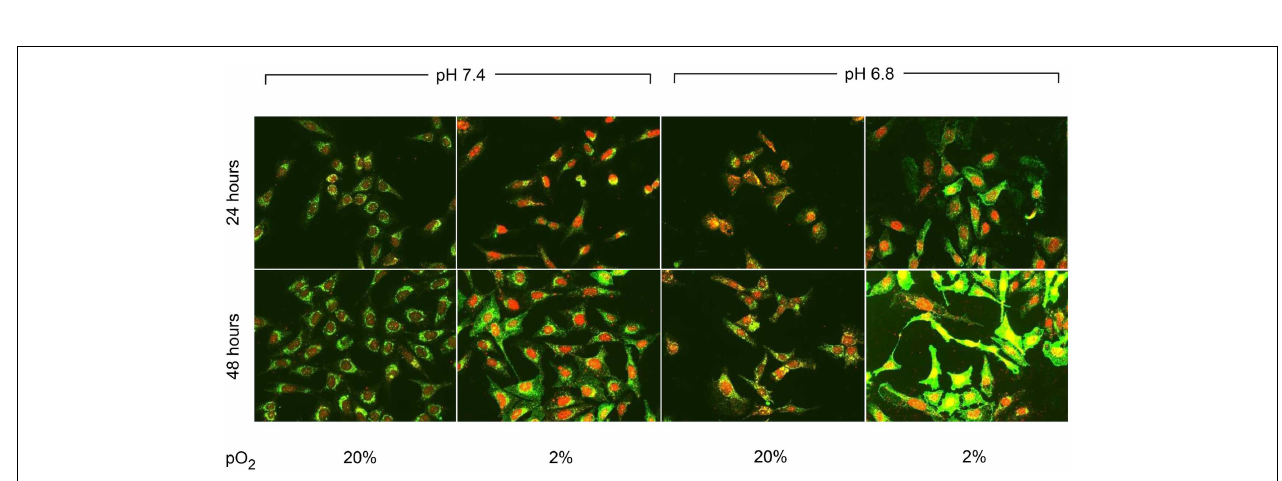
FIGURE 8 | Immunofluorescent staining demonstrated the changes in CA IX (green) and HIF-1 α (red) expression at 24 and 48h of incubation in varying microenvironmental conditions . CA IX expression was highly promoted by the combination of acidic pH and hypoxia.